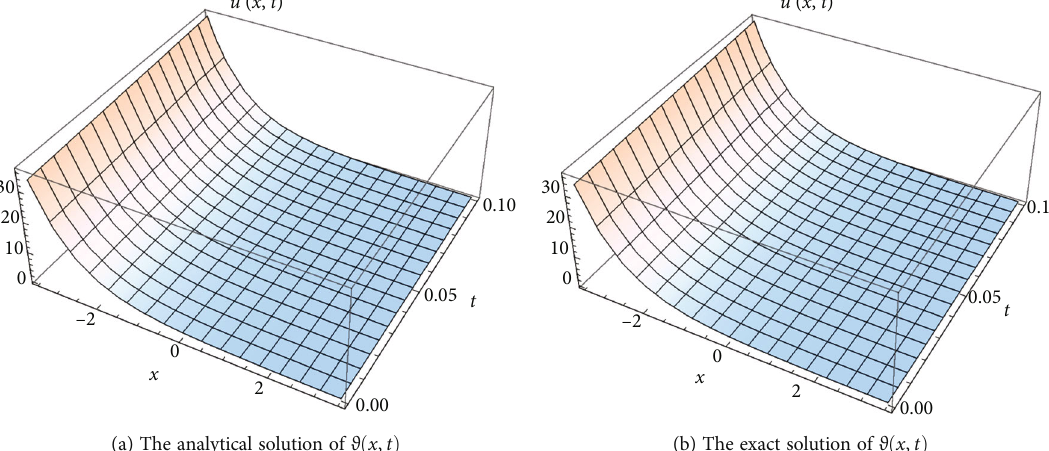
Figure 1: The surface solution of GD equation for Example 1.